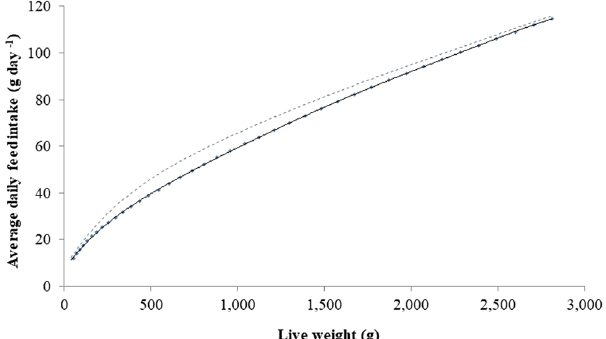
Figure 1. The average daily feed intake of a current fast-growing broiler ( ) and the potential average daily feed intake defined by the apparent biological limit of feed intake (broken line). Based on the data presented by Leeson et al . 36